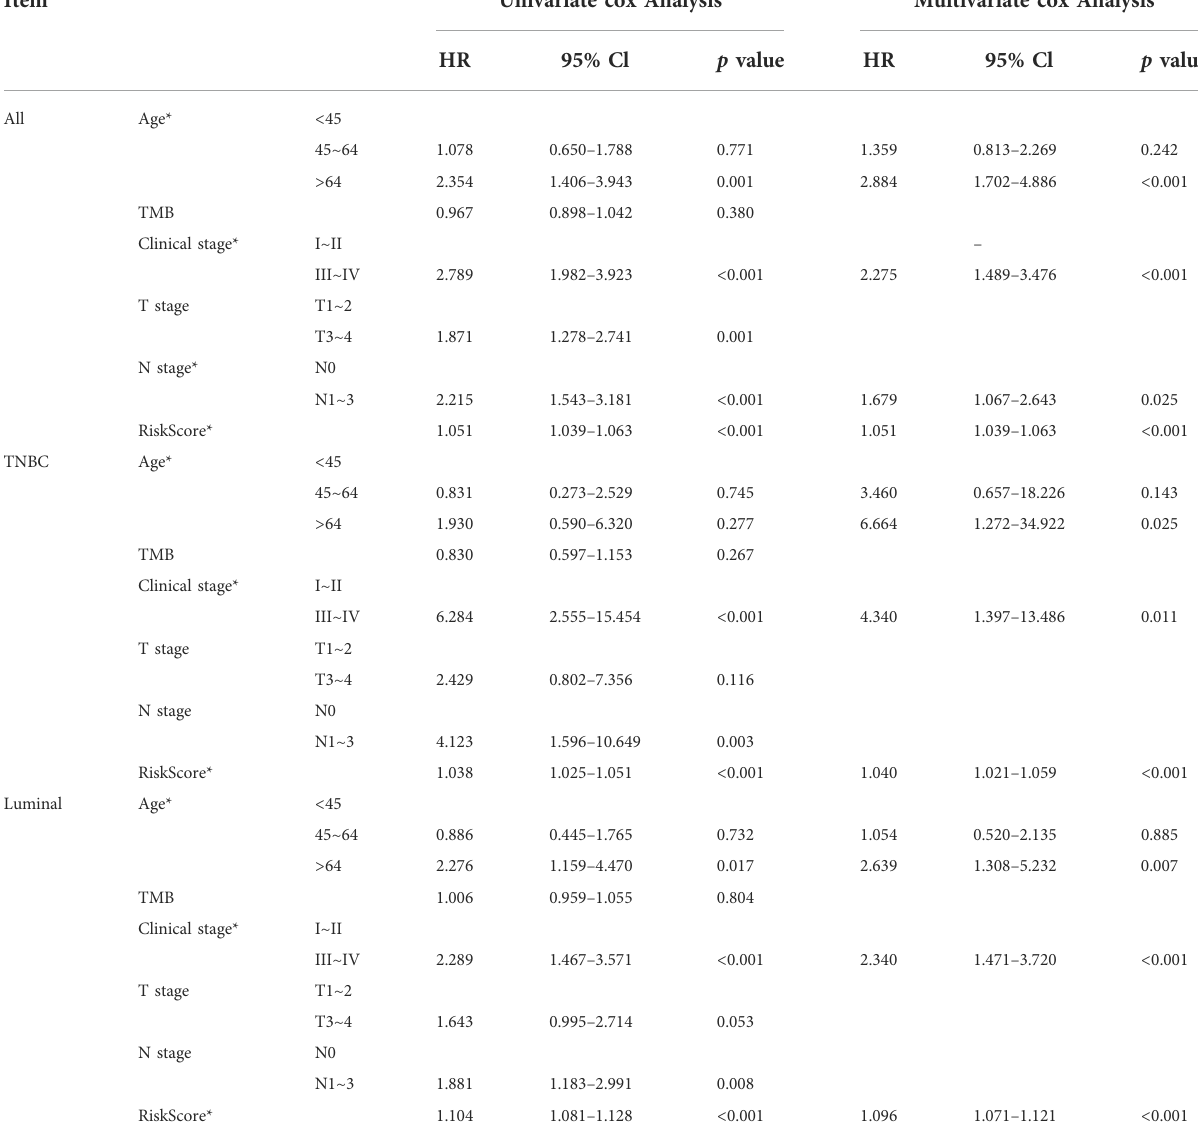
TABLE 2 | Identifying clinical factors in the nomogram. (1) Age, clinical stage, N stage, and risk-score were selected in all cohorts; (2) Age, clinical stage, and risk-score were selected in the luminal cohort; (3) Age, clinical stage, and risk-score were selected in the TNBC cohort.